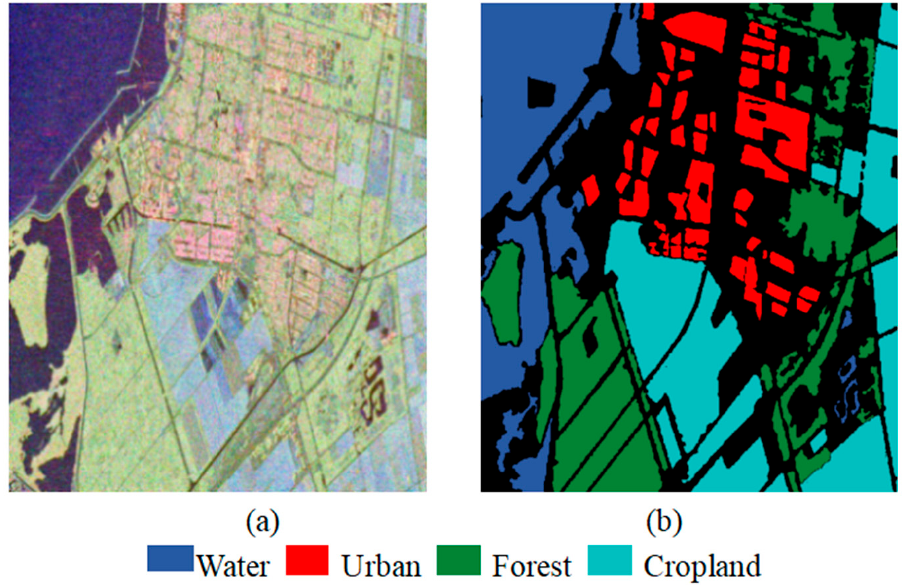
Remote Sens. 2023 , 15 , x FOR PEER REVIEW 11 of 22